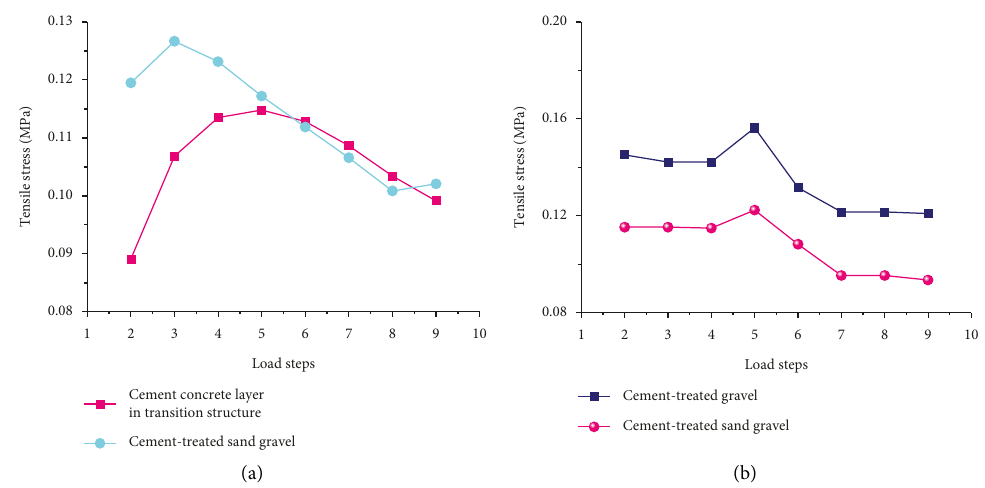
Figure 15: Tensile stress at the bottom of base course outside the tunnel. (a) Tensile stress at the bottom of base course in Str-1. (b) Tensile stress at the bottom of base course in